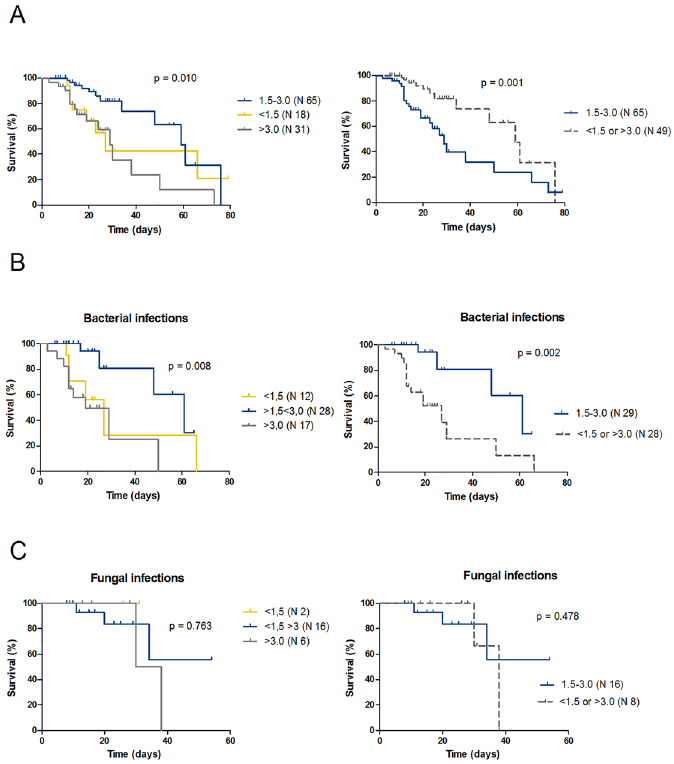
Fig 2. Survival curves according to the median doses of granulocytes received. The survival was determined as the interval between the first day with ANC < 500/ μ L and death or neutropenia recovery. Differences were estimated using the log-rank test. A) Survival of neutropenic patients during overall 114 infectious episodes. B) Survival of neutropenic patients during bacterial infections C) Survival of neutropenic patients during disseminated fungal infections. Yellow curves represent patients in the low-dose group (median PMN dose inferior to1.5x10 8 /Kg), blue curves represent patients in the standard-dose group (median PMN dose 1.5 – 3.0x10 8 /Kg) and grey curves represent patients in the high-dose group (median PMN dose greater than 3.0x10 8 /Kg), dotted curves represent cumulated patients in low and high dose